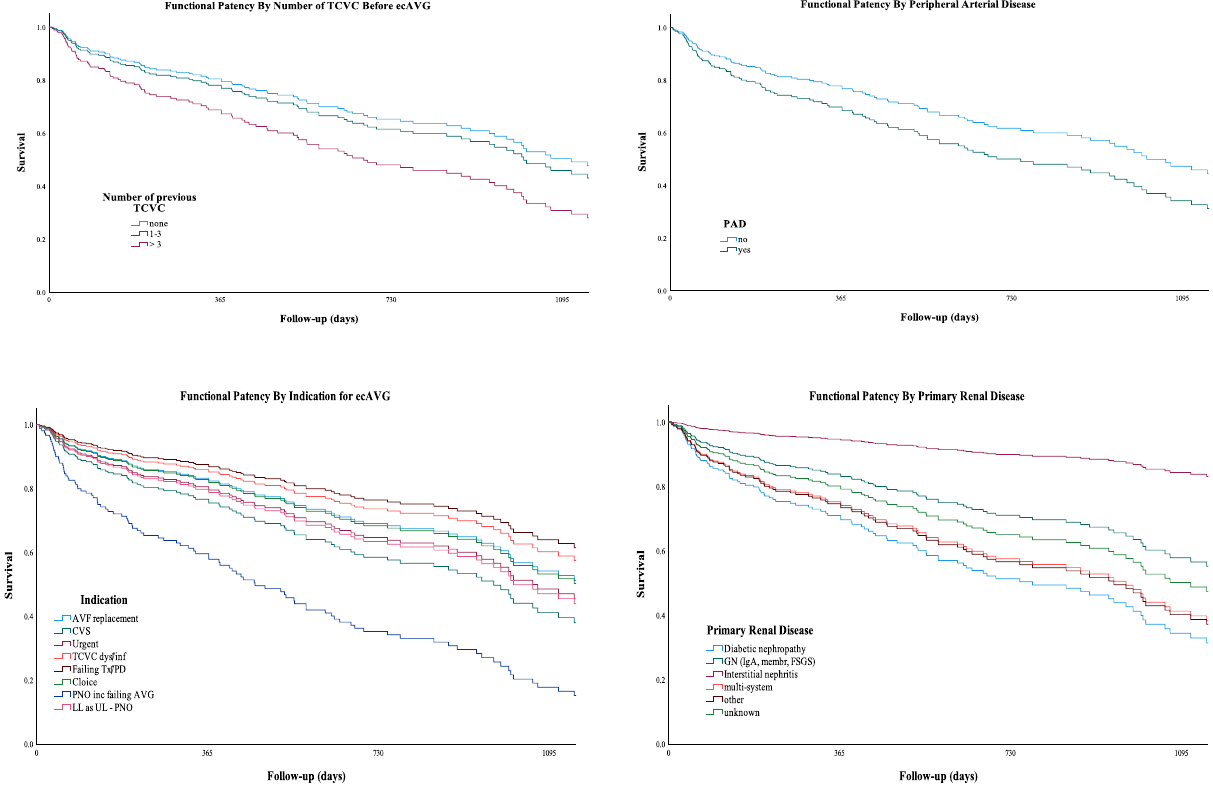
Figure 2. Functional patency survival curves by significant co-variables: body mass index, peripheral arterial disease, hypertension, primary renal diagnosis, and number of previous TCVC on univariate